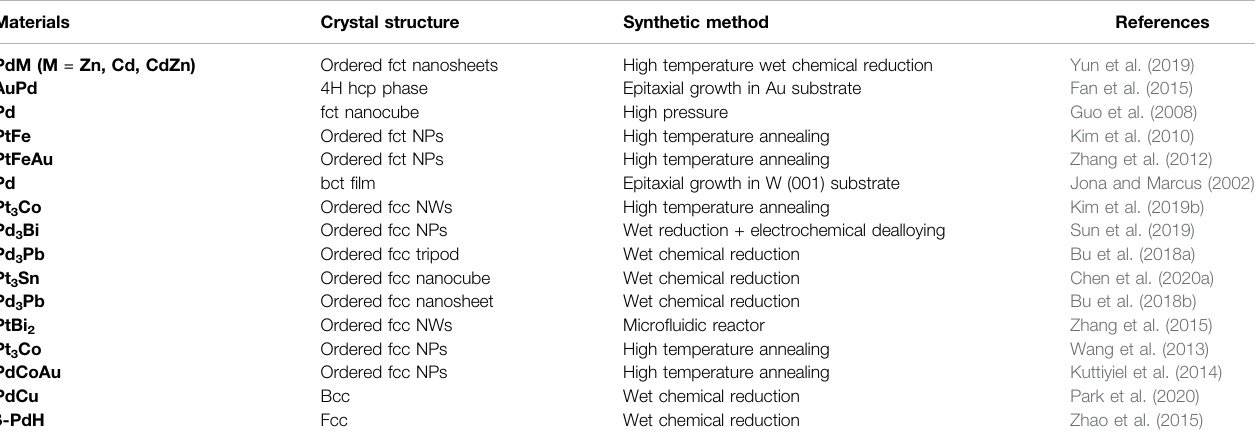
TABLE 2 | Summary of methods for synthesizing new crystal structures of PGM based NCs.